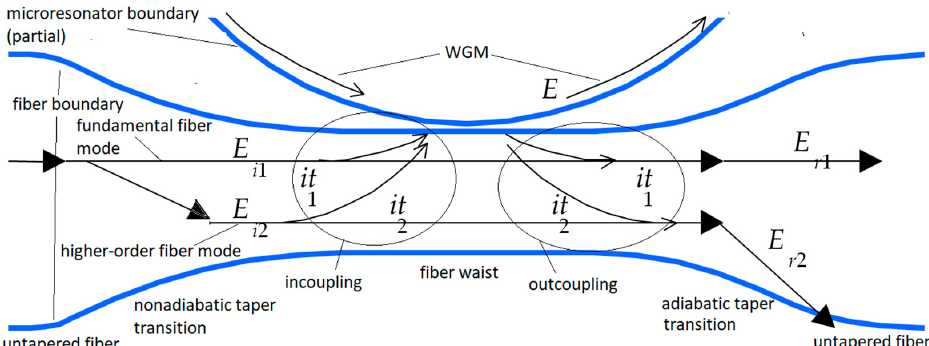
Figure 1. Multimode input to a microresonator. (Fiber not to scale but enlarged to show detail). Light in the untapered single-mode fiber strongly couples into two fiber waist modes of amplitudes E i 1 and E i 2 . They then couple weakly into a WGM of amplitude E with input coupling coefficients it 1 and it 2 , respectively. The WGM then couples out into throughput modes of amplitudes E r 1 and E r 2 with output coupling coefficients equal to the input coefficients. Only the fundamental throughput mode survives to be detected, since the higher-order mode cannot propagate in the untapered single-mode fiber.